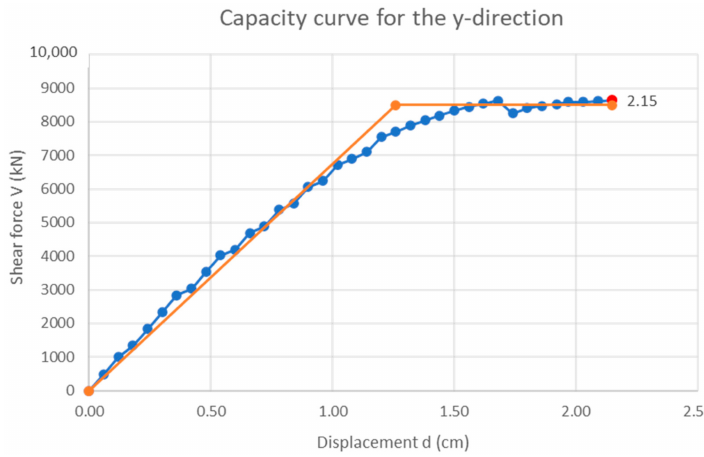
Figure 18. The most relevant capacity curve for y-direction.